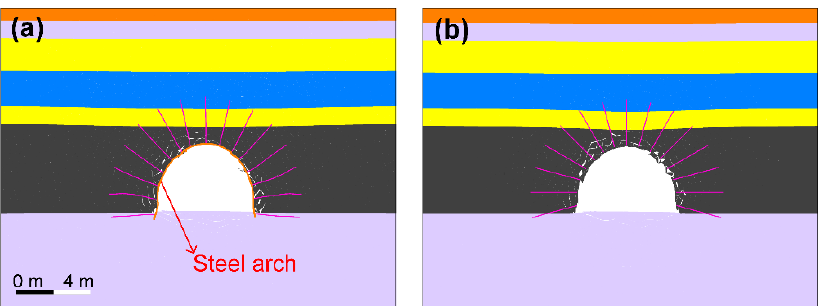
Figure 21. ( a , b ) are the macroscopic failure patterns of the tunnel with and without a steel arch. The dynamic calculation time is 20 ms.